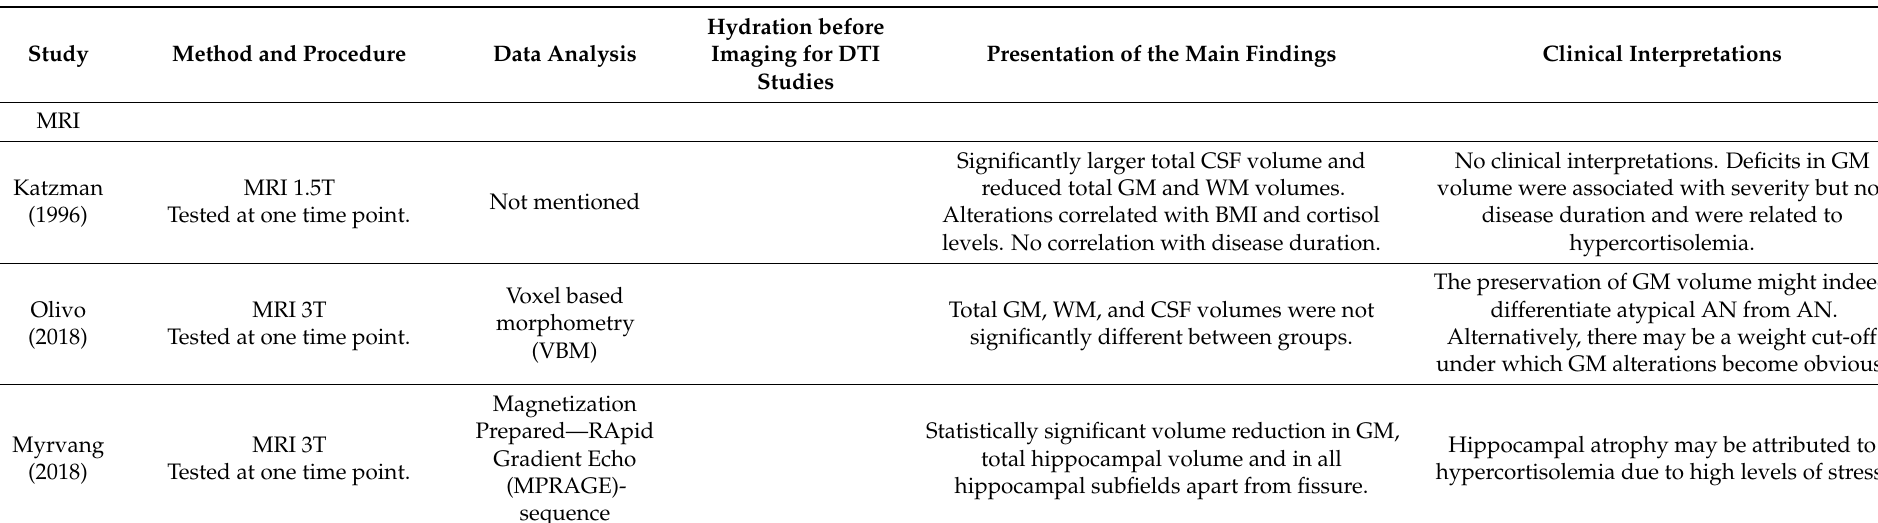
Table 2. Structural imaging studies—methods, main findings and clinical